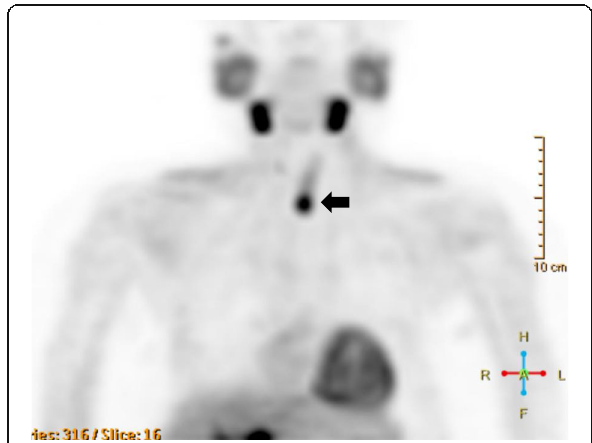
Fig. 4 MIBI scintigraphy findings. MIBI accumulated in the lower mass (arrow) but not in the upper mass